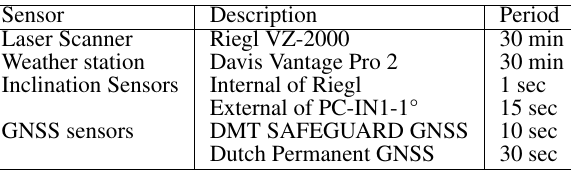
Table 1. Specifications of all sensors used to collect data for this analysis.